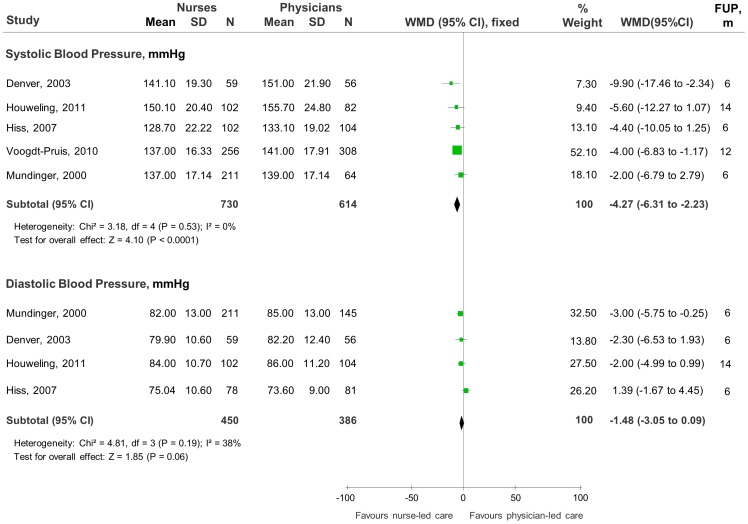
Comparison of blood pressure control between nurse-led care and physician-led care.Studies are listed in order of decreasing weighted effect size. Abbreviations: mmHg = millimetres of mercury; SD = standard deviation; N = total number of patients in the analysis; WMD = weighted mean differences; CI = confidence interval; df = degrees of freedom; I2 = heterogeneity between trials; FUP = Follow-up; m = months.